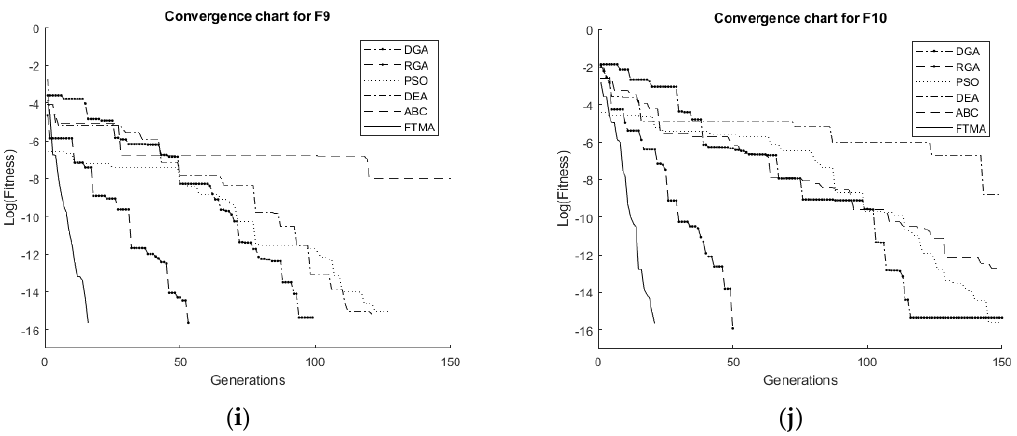
Figure 2. Convergence charts for the ten benchmark functions. ( a ) F1, ( b ) F2, ( c ) F3, ( d ) F4, ( e ) F5, ( f ) F6, ( g ) F7, ( h ) F8, ( i ) F9, and ( j ) F10.